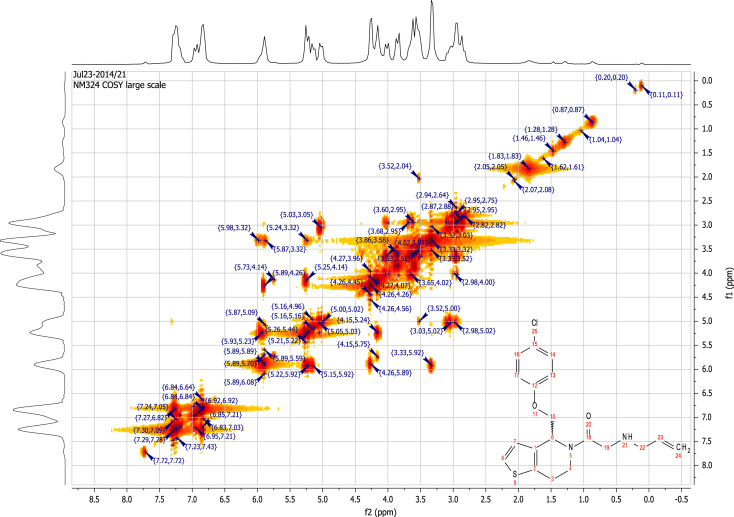
2D COSY (400 MHz,
CDCl3) of RU-SKI 41
(9a).